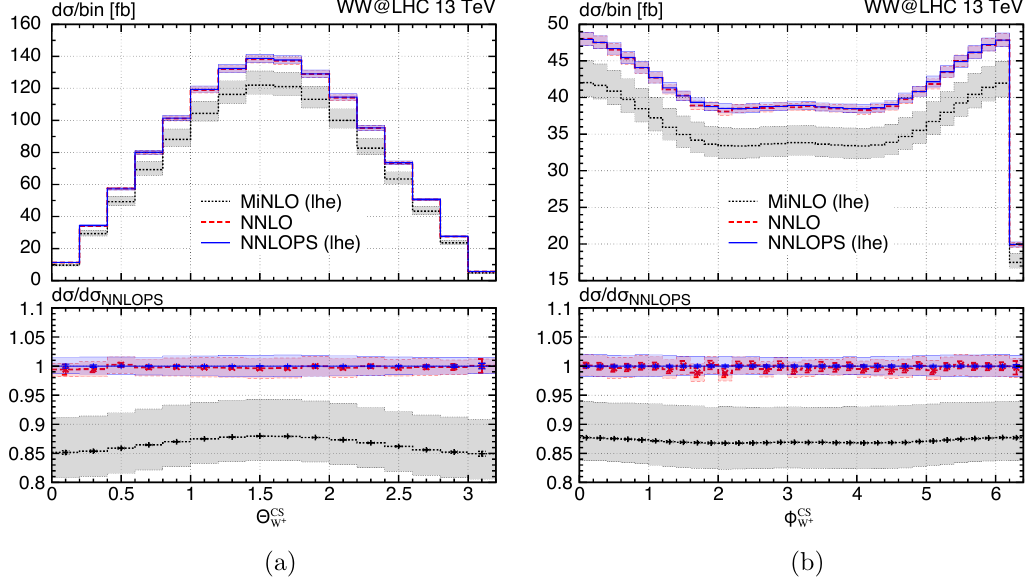
and (b) (cid:30) CS . W + W +